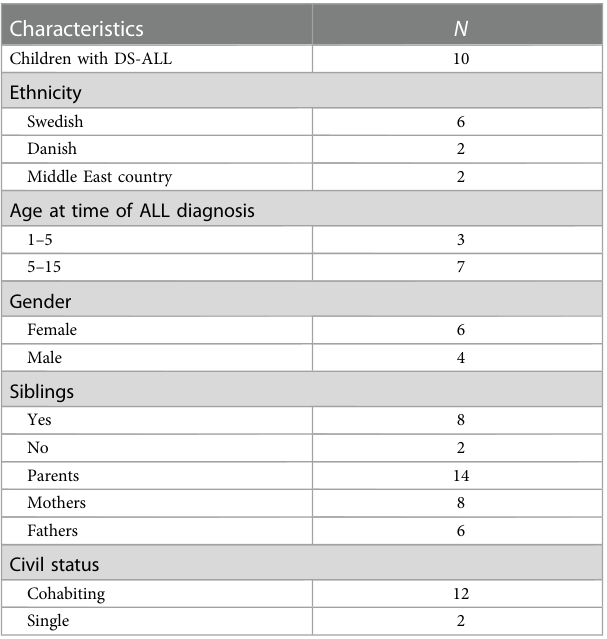
TABLE 1 Characteristics of study